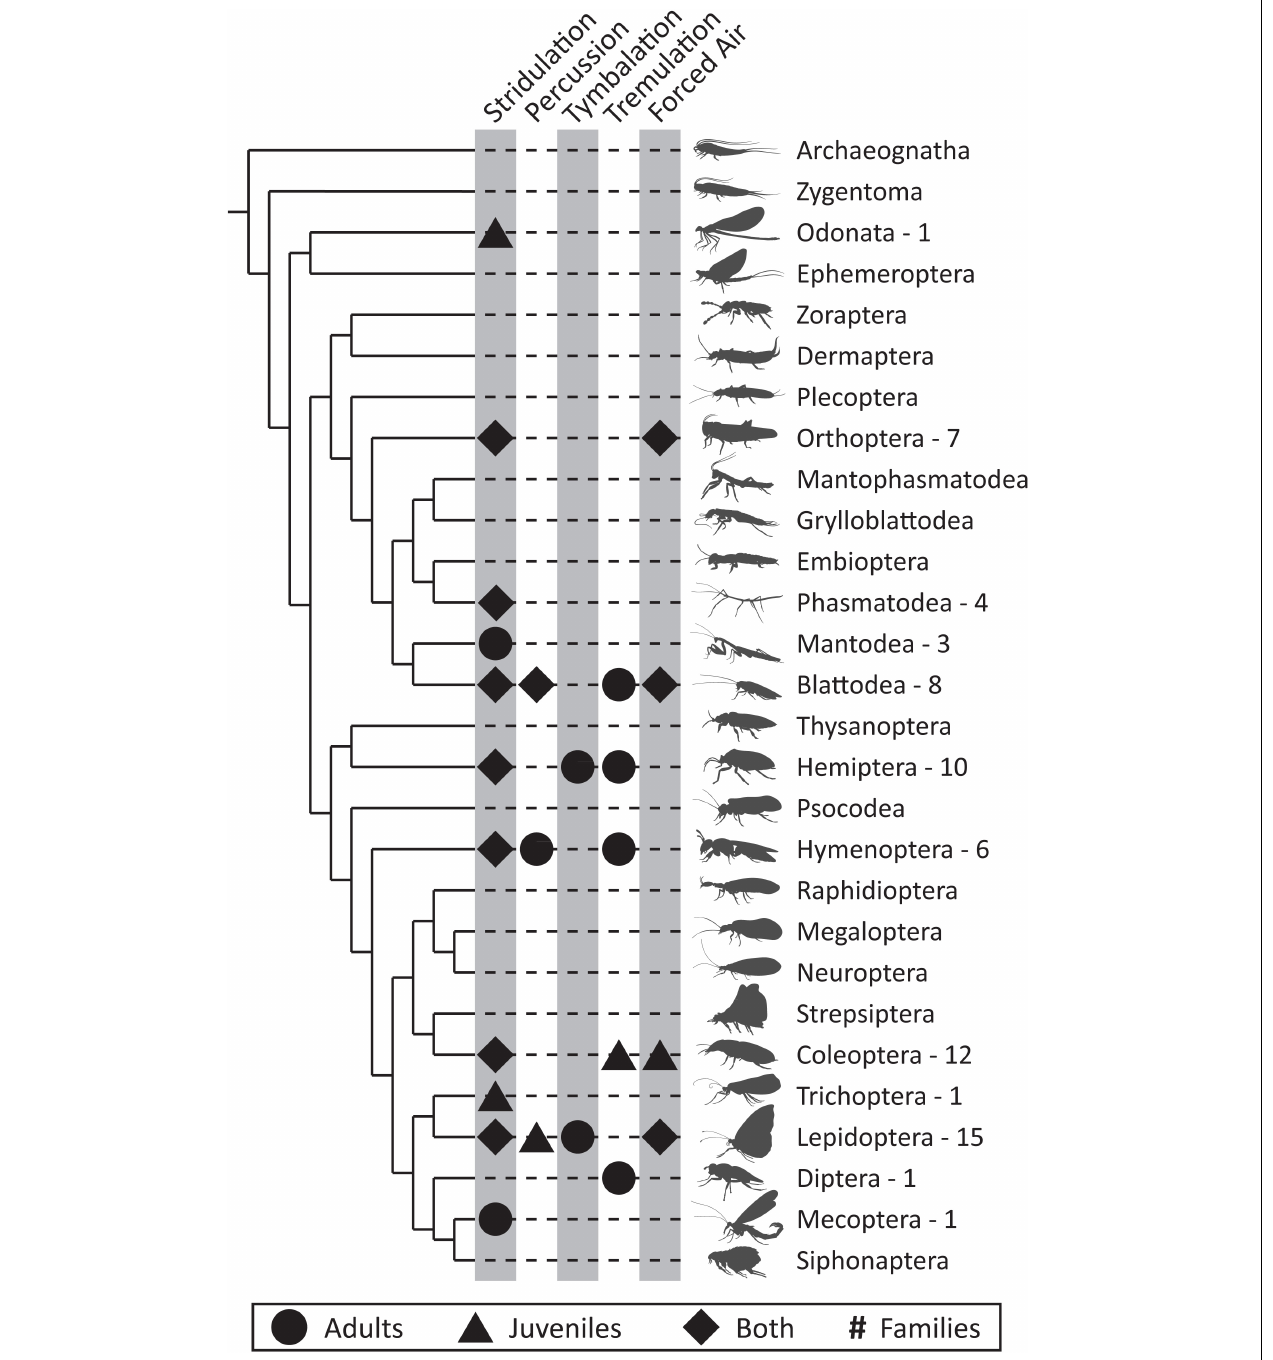
FIGURE 1 | Distribution of defense sounds across orders and life stages of the Class Insecta. The five different mechanisms used to produce defense sounds (stridulation, percussion, tymbalation, tremulation, and forced air) are indicated within their respective columns. Shapes represent the life stage at which defensive sound production occurs, with pupae included under “Juveniles.” Numbers represent the number of families within that order where defensive sound production has been noted. Cladogram adapted from Misof et al.